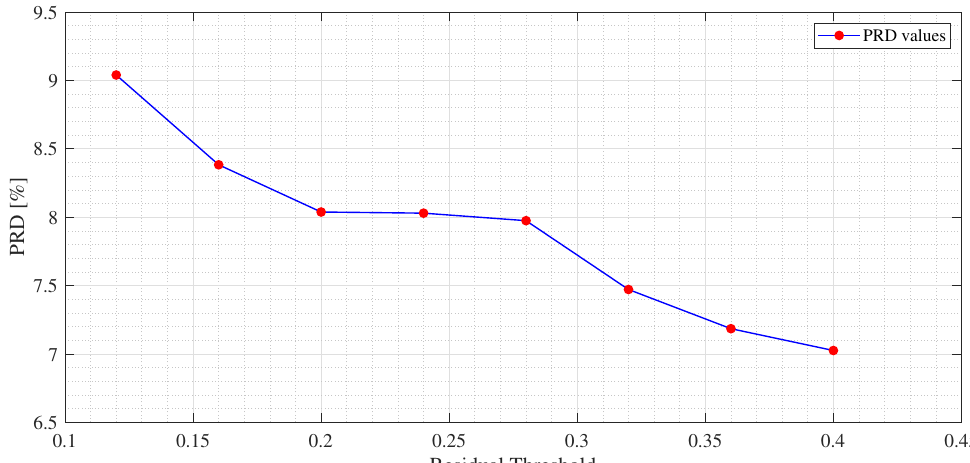
Figure 5. PRD values for several values of the Residual Threshold of the M-OMP for USR = 9 for the MIT-BIH arrhythmia database signal No. 122.